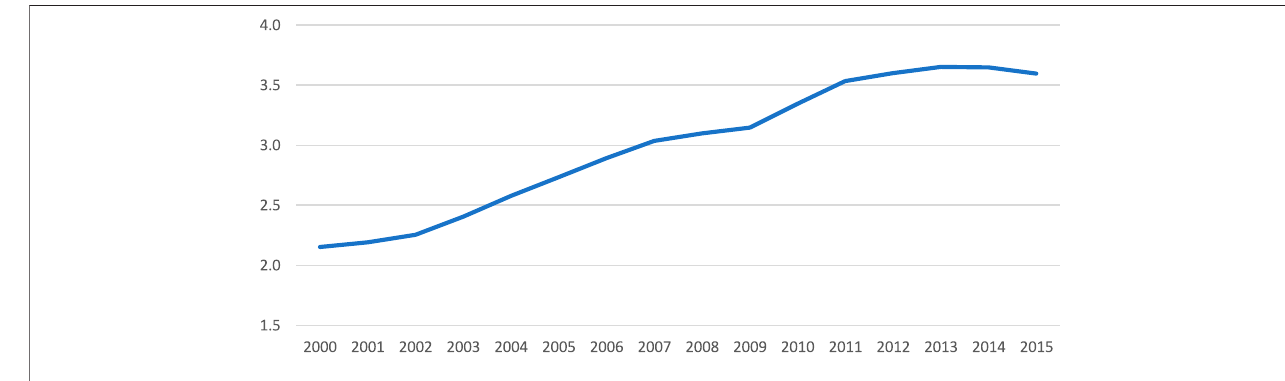
FIGURE 1 | CO 2 emission per